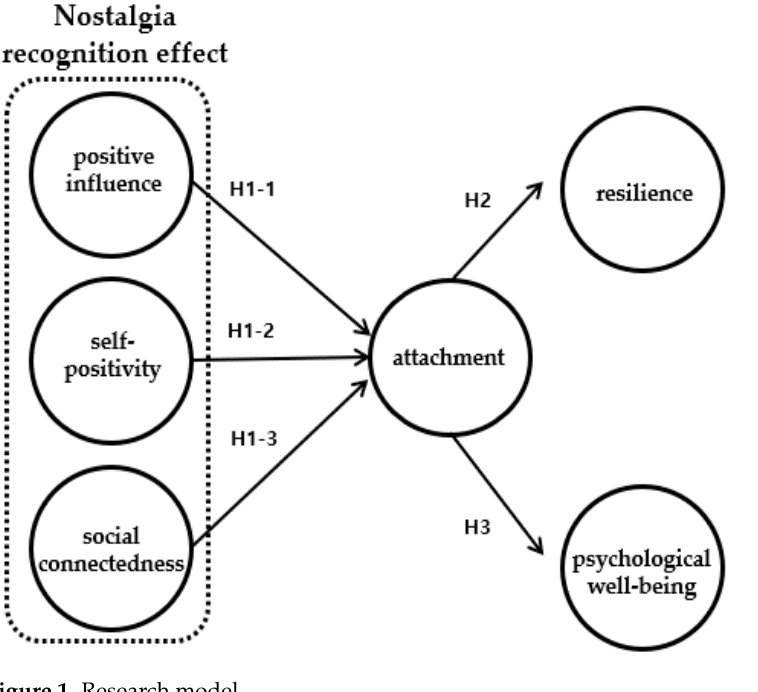
Figure 1. Research